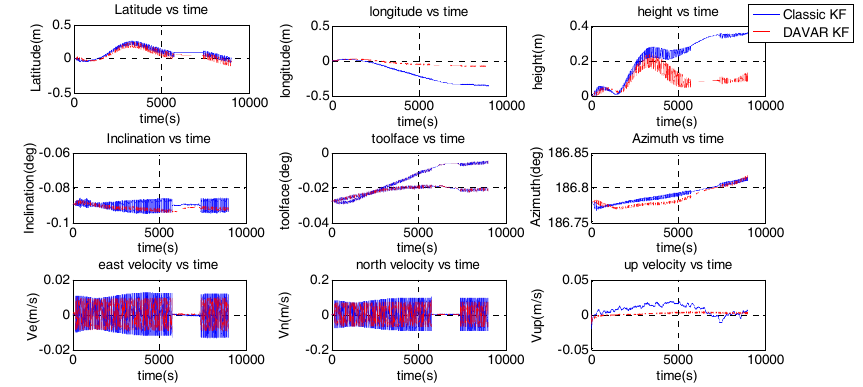
Figure 7. Navigation results of the fixed-frequency vibration.